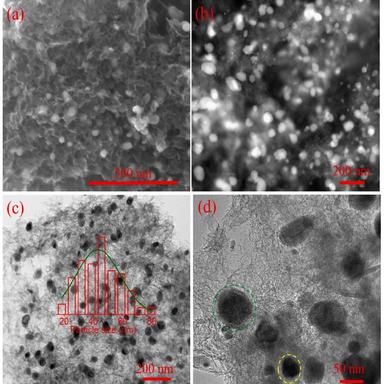
(a) Typical SEM, (b) HADDF-STEM and (c-d) TEM images of Co-Co2P @ NC (inset of (c): corresponding particle size distribution histogram).